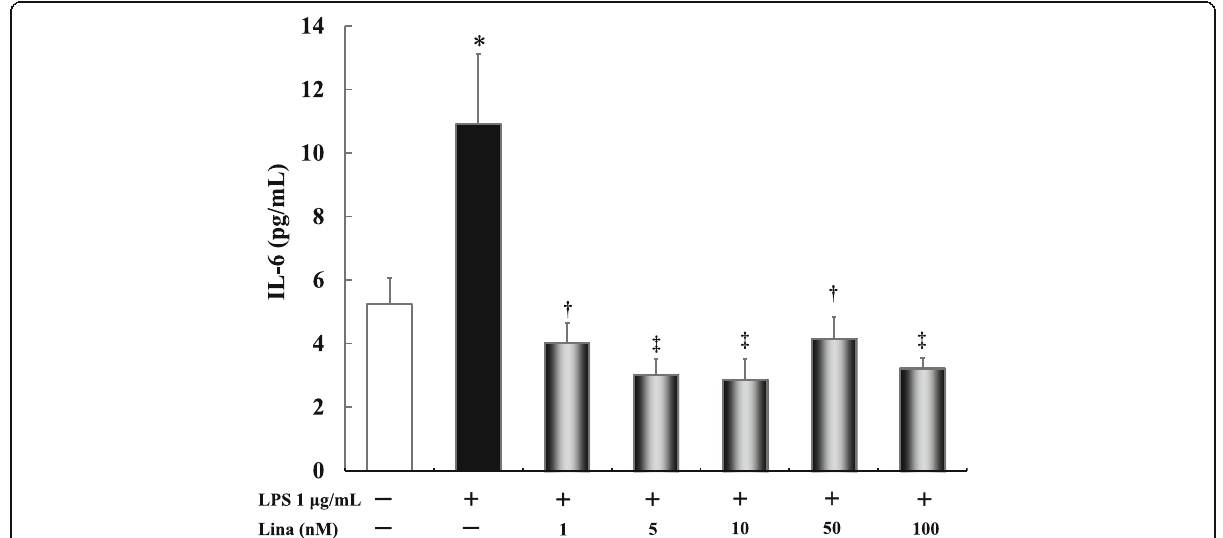
Fig. 4 Effects of linagliptin treatment on LPS-induced interleukin IL-6 production after 5 h. Human U937 monocytes were treated with LPS and/or linagliptin. IL-6 levels in the supernatants were determined via ELISA after 5 h of treatment. * P < 0.001 vs. control; † P < 0.001 vs. LPS 1 μ g/mL; ‡ P < 0.0001 vs. LPS 1 μ g/mL. Lina, linagliptin